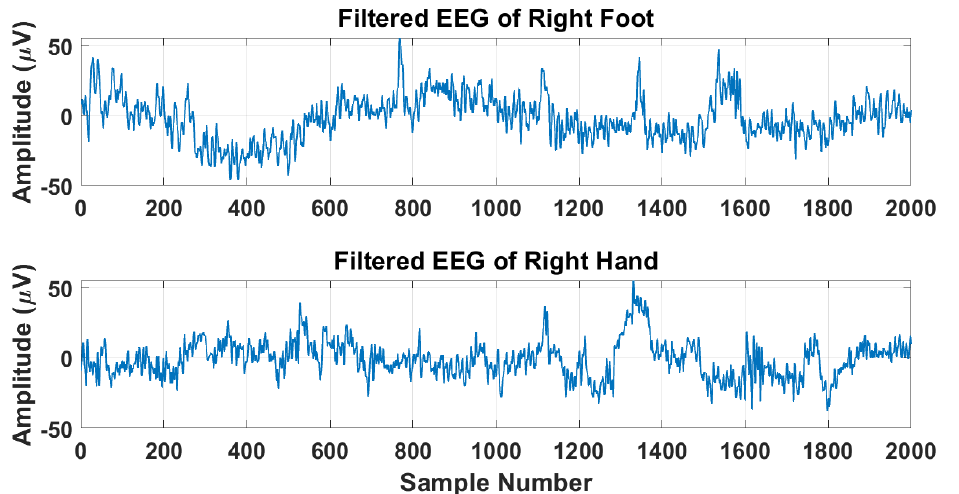
Figure 2. Examples of EEG signals for RF and RH brain